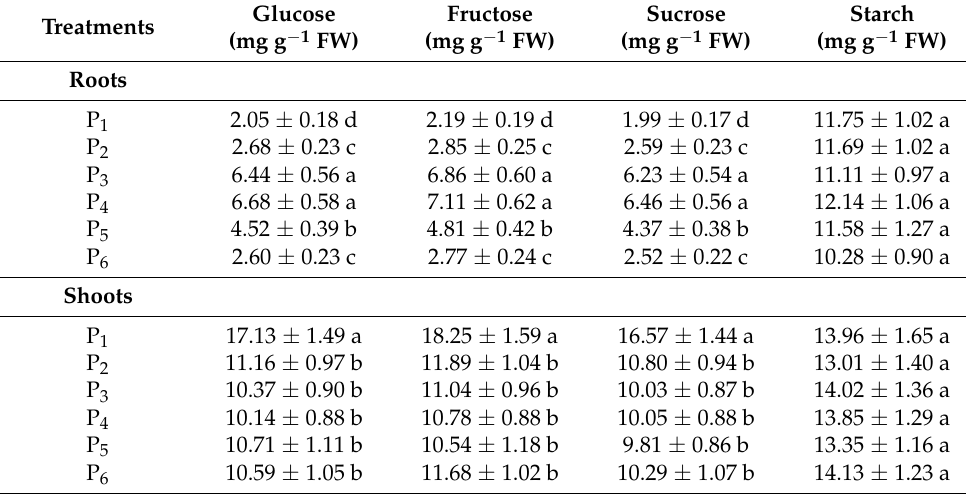
Table 1. Effects of different P treatments on the accumulation of non-structural carbohydrates in the roots and shoots of green bean plants at the end of the experiment. n = 6. Means ± standard deviation within columns with different lower-case letters are significantly different at p < 0.05 (one-way ANOVA and LSD tests).